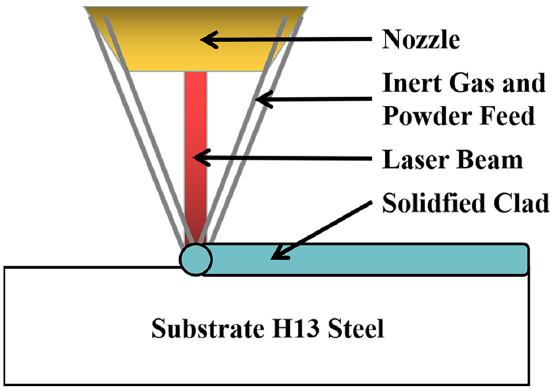
Figure 1. Schematic diagram of laser cladding process. Table 3. Multiple variations in processing parameters of coatings.